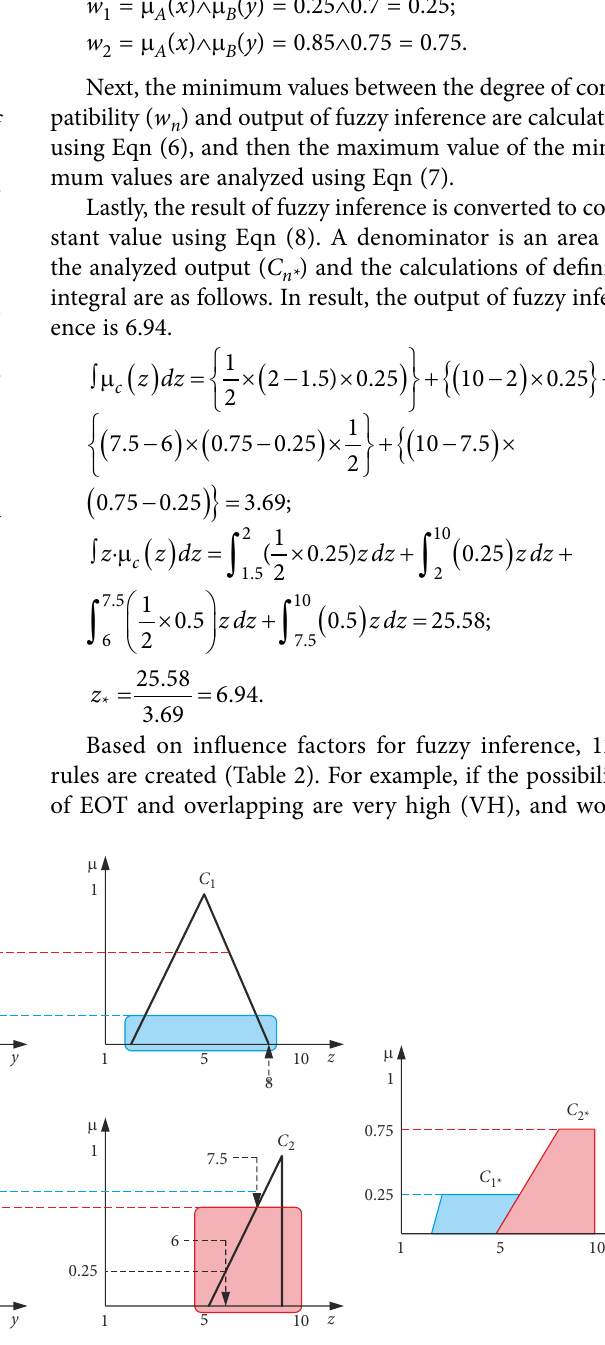
Figure 3. Example of fuzzy